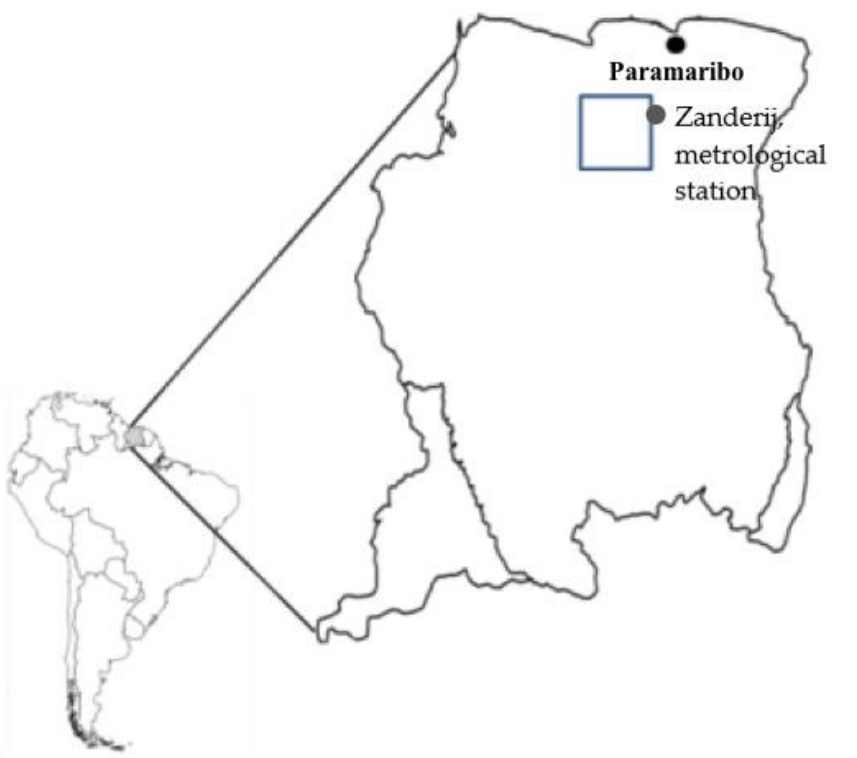
Figure 1. Map of Suriname showing the sample collection site and the metrological station, Zanderij. The square shows the origin of the samples.